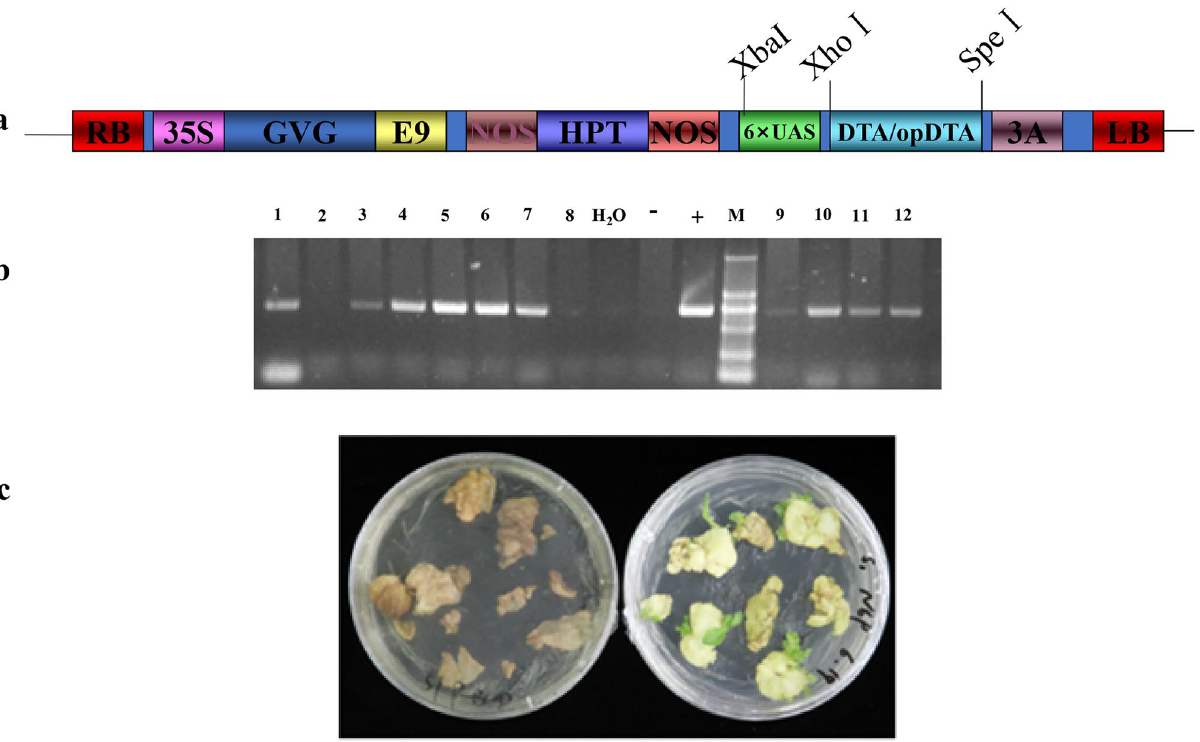
Figure 2. Optimized DTA gene exhibits weak toxicity to tobacco leaf discs in DEX-inducible system. ( a ) Schematic diagram of the recombination vector pTA7002::DTA and opDTA; ( b ) PCR assay to detect the opDTA gene in T0 transgenic plants; c: leaf disc of tobacco after infecting by Agrobacterium tumefaciens harboring pTA7002::DTA (left) and optimized pTA7002::opDTA (right).